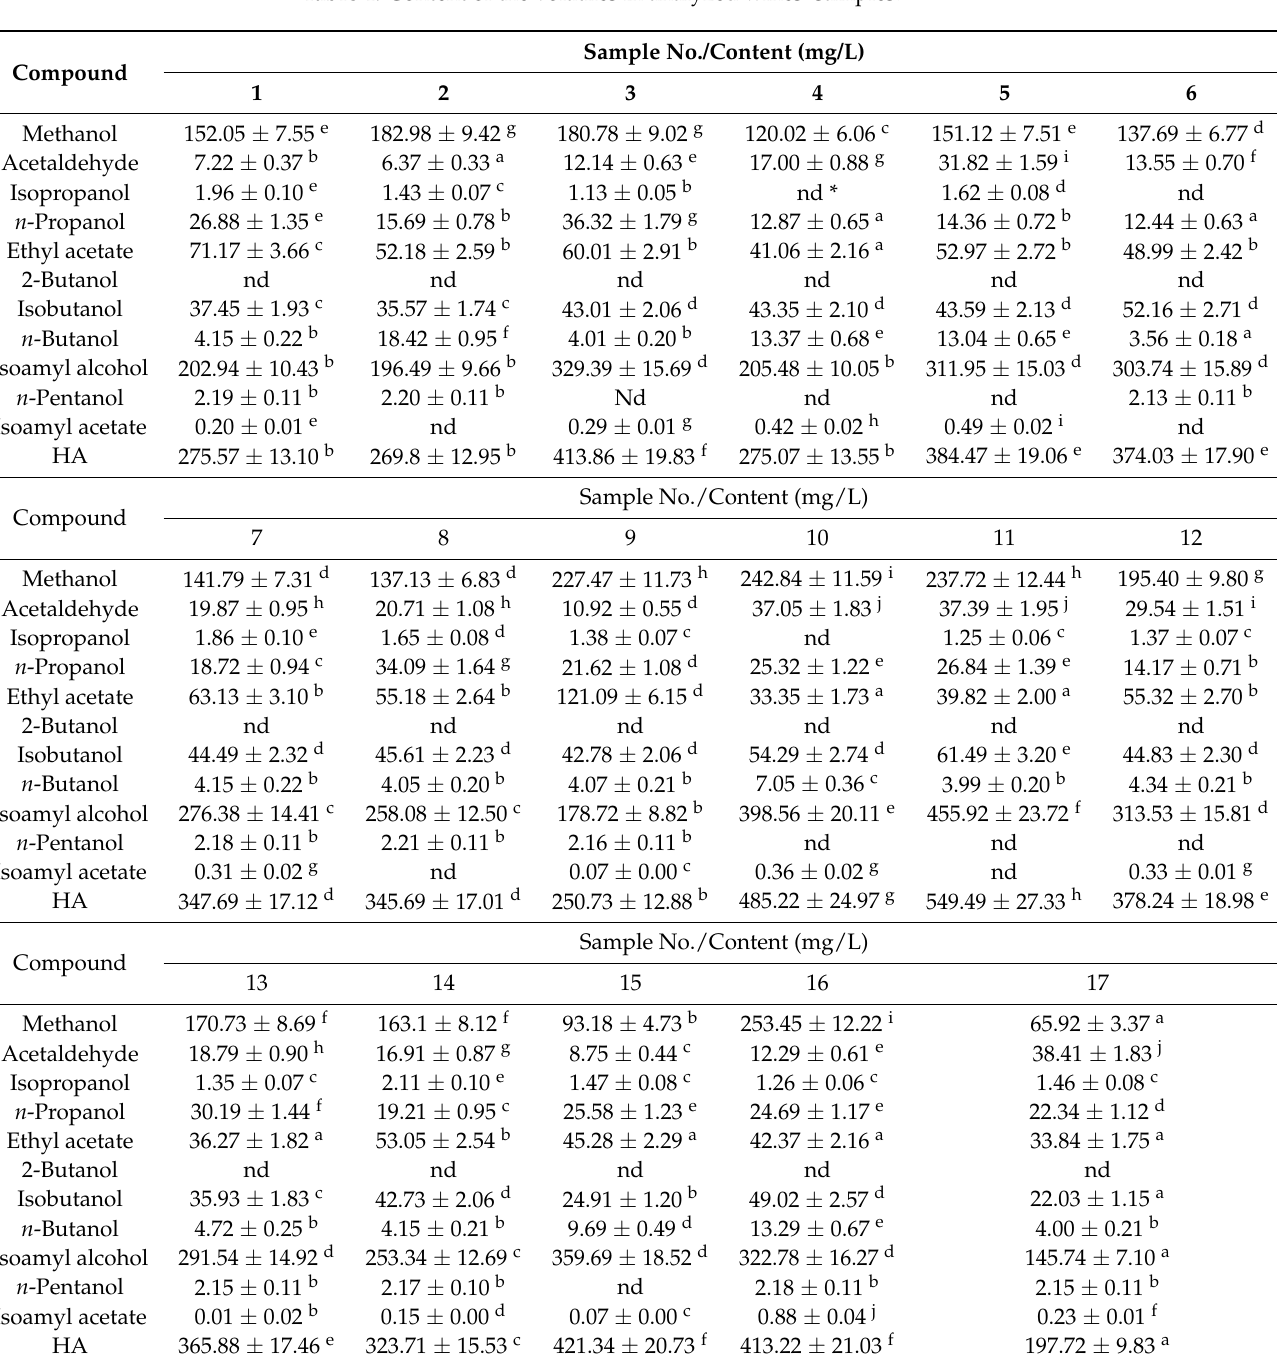
Table 4. Content of the volatiles in analyzed wines’